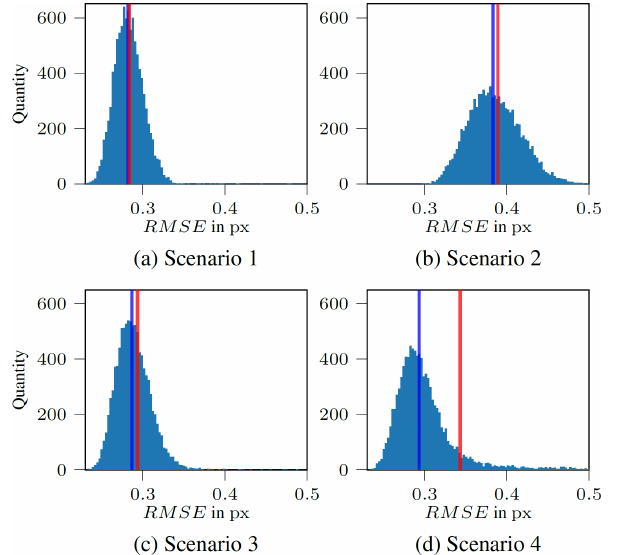
Figure 6. RMSE histograms resulting from the utilization of the different parameter sets in Table 1 for the multicalibration of N = 15, M = 10000 without data filtering. The red line indicates the mean and the blue line the median value. The x axis is limited to 0 . 5px to allow better visualization of the distribution; the truncated maximum values are max(RMSE S1 ) = 0 . 59px, max(RMSE S2 ) = 0 . 98px, max(RMSE S3 ) = 0 . 82px and max(RMSE S4 ) = 4 . 21px. Due to the presence of a few comparatively large outliers in